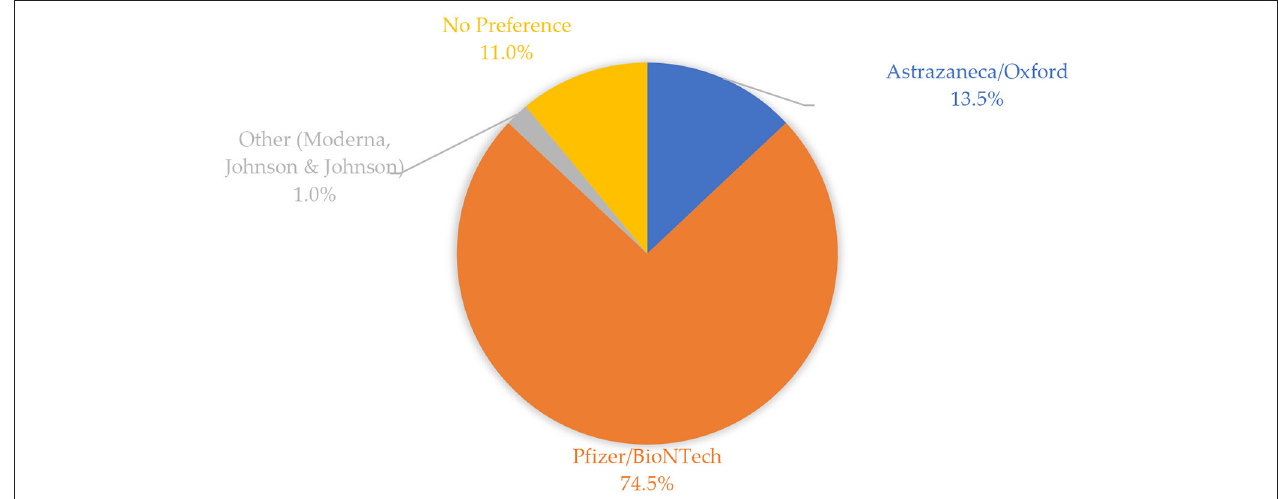
FIGURE 1 | Frequencies of vaccines preferred by study participants.